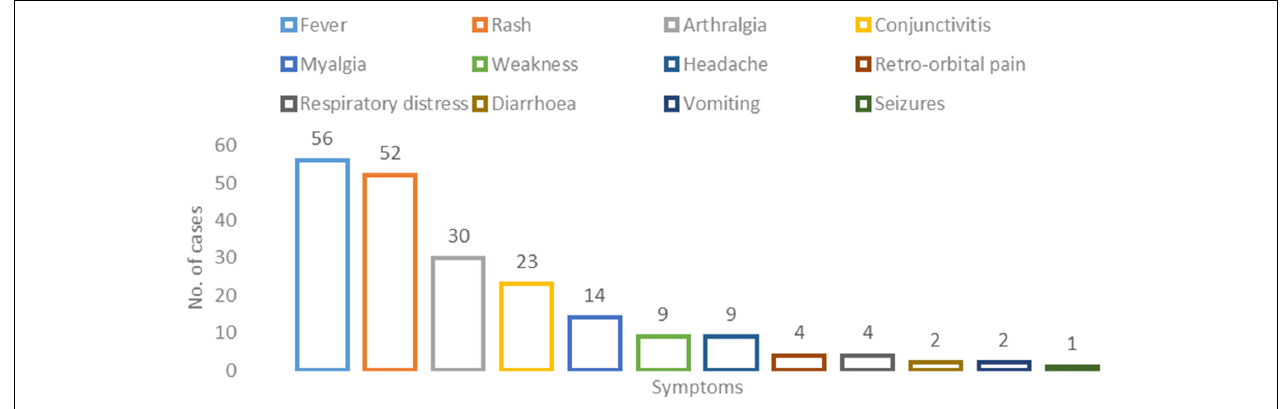
FIGURE 2 | Clinical profile of the Zika virus positive cases: X -axis represents the number of cases per symptom and Y -axis represents the symptom type.